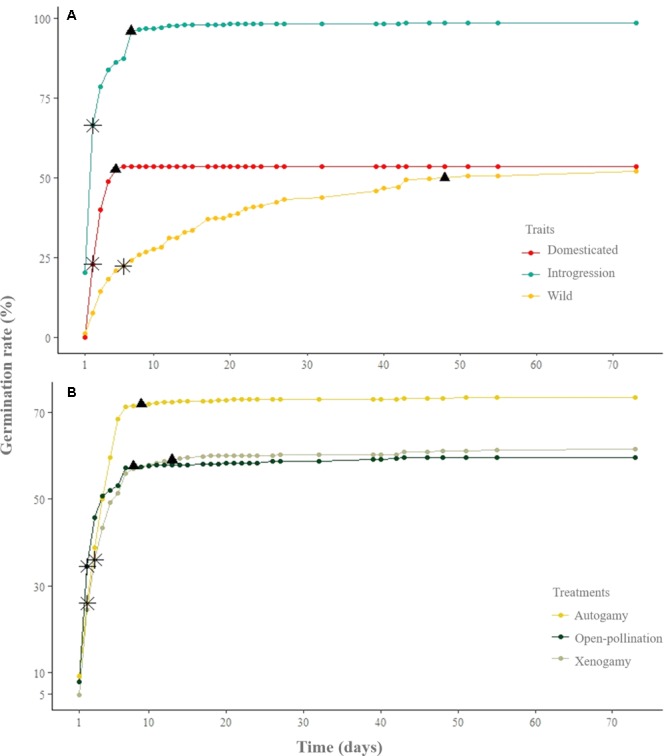
(A) Germination rate of seeds from domesticated plants, with introgressive hybridization plants (SPM), and wild plants (CPM and YPM). (B) Germination rate of pollination treatments from all study groups. The asterisk and the triangle represent 50 and 95 percent of the total of germinated seeds, respectively.